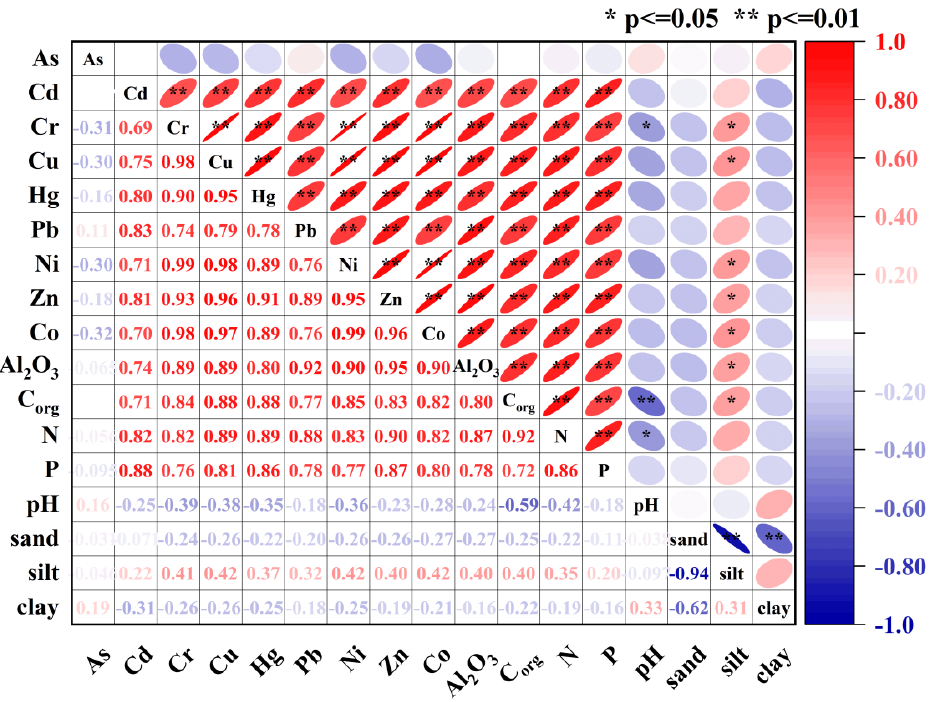
Figure 5. The overall Pearson’s correlation coefficients between heavy metals and physico − chemical properties.